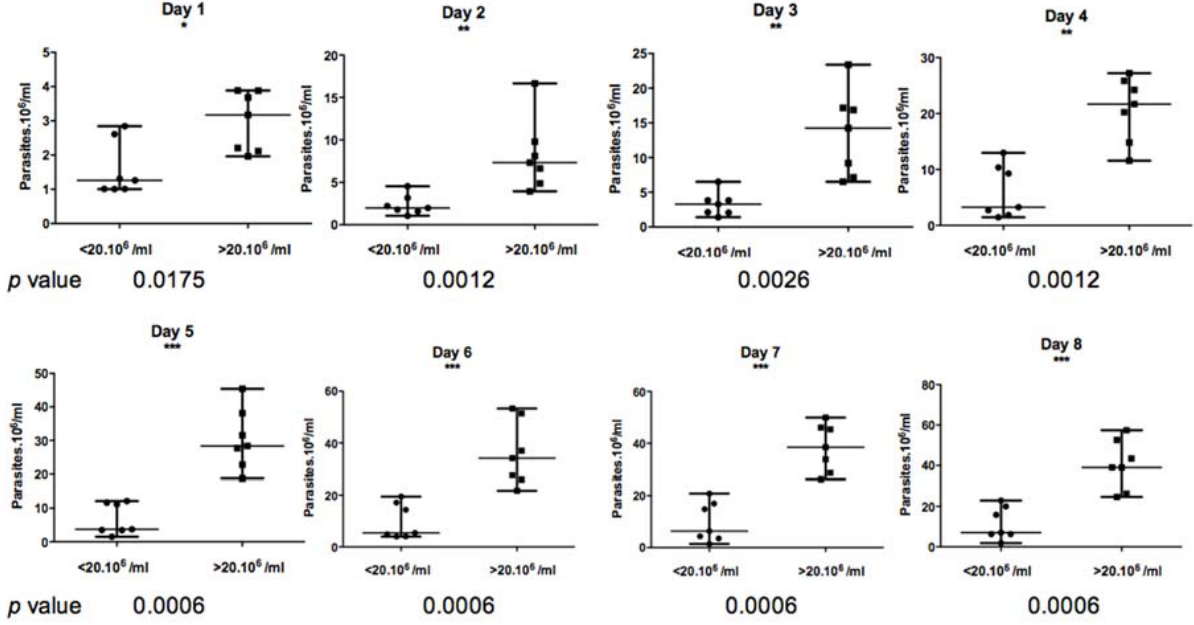
Figure 6. Non-parametric two-tailed t test measuring the difference between the two L. major isolate groups showing differential in vitro growth kinetics. The first group of isolates reached less than 2 × 10 7 parasites per mL on the eighth day of culture, whereas the second group exceeded 2 × 10 7 parasites growth per mL. *, ** and *** indicate significant ( p < 0.05), strongly ( p < 0.01) or highly ( p < 0.001) statistically significant values